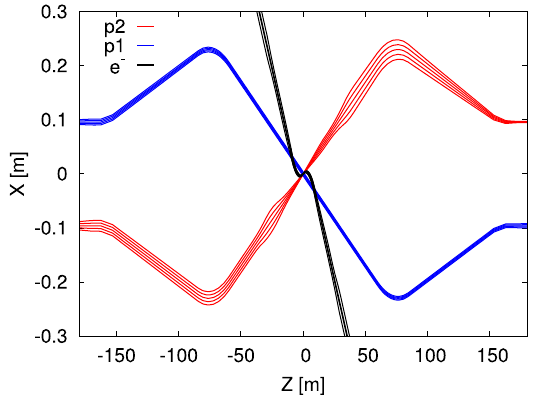
FIG. 2. Schematic view of the trajectories dictated by the corresponding recombination dipoles of proton beams 1 and 2 (blue and red respectively), and the electron beam (black) in IR2 with 5 σ and 10 σ envelopes